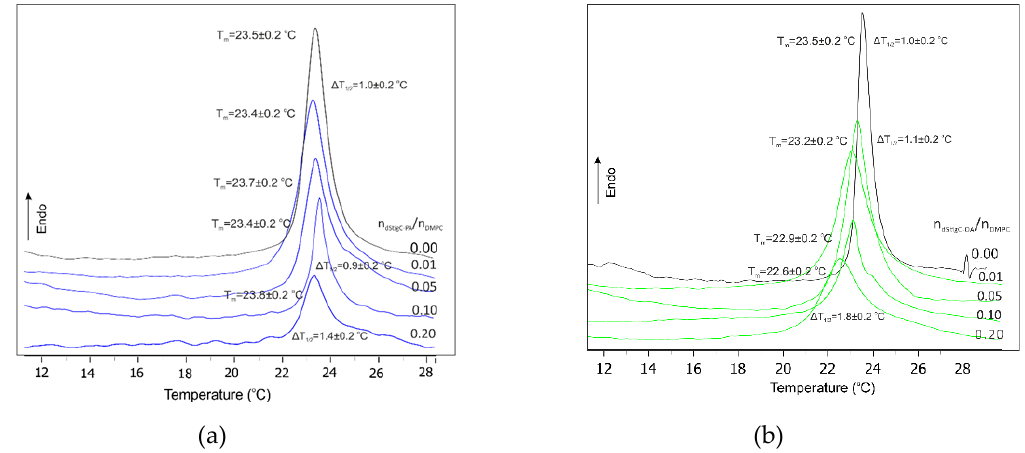
Figure 2. ( a ) Calorimetric curves of DMPC and dStigC-PA/DMPC multilamellar liposomes; ( b ) calorimetric curves of DMPC and dStigC-OA/DMPC multilamellar liposomes.